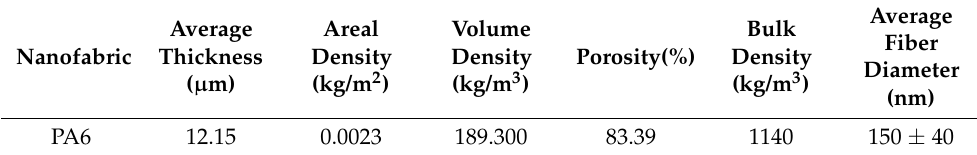
Table 1. Properties of PA6